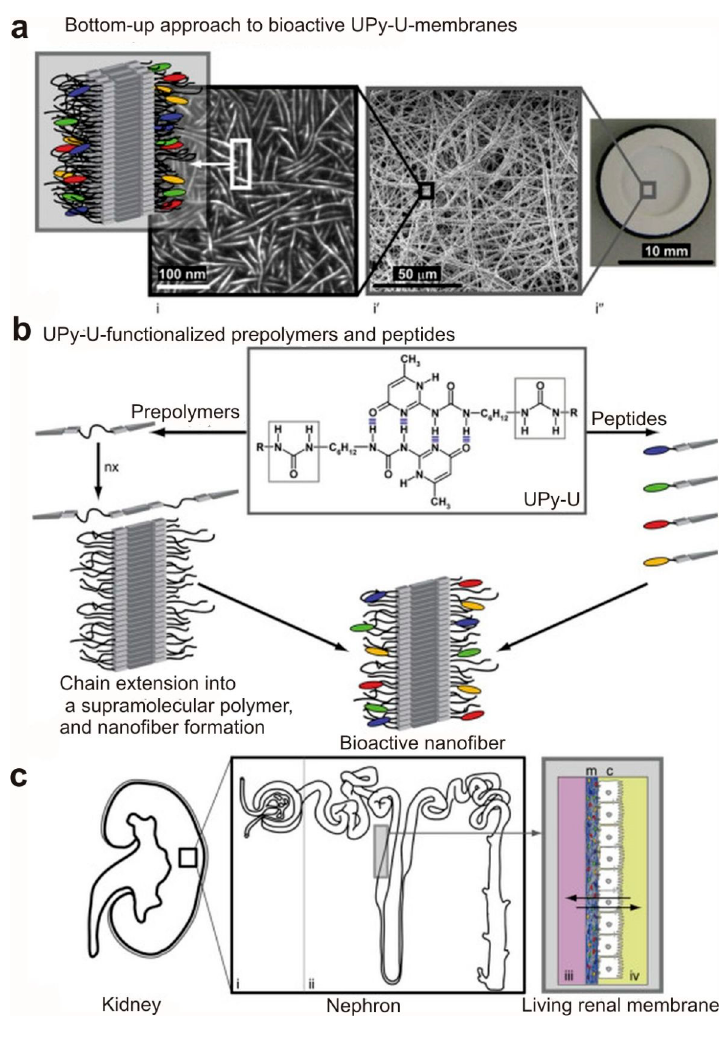
Figure 4. ( a ) Bottom-up method to generate bioactive UPy-U membranes; ( b ) dimers are produced via Fourfold hydrogen bonding ureido-pyrimidinone (UPy) moieties and load in lateral manner through extra hydrogen bonding in the middle of urea (U) functionalities; therefore, turning into nanofiber structures; ( c ) the representation of kidney and its different segments. Reproduced with permission [123]. Copyright 2010 Elsevier Ltd.